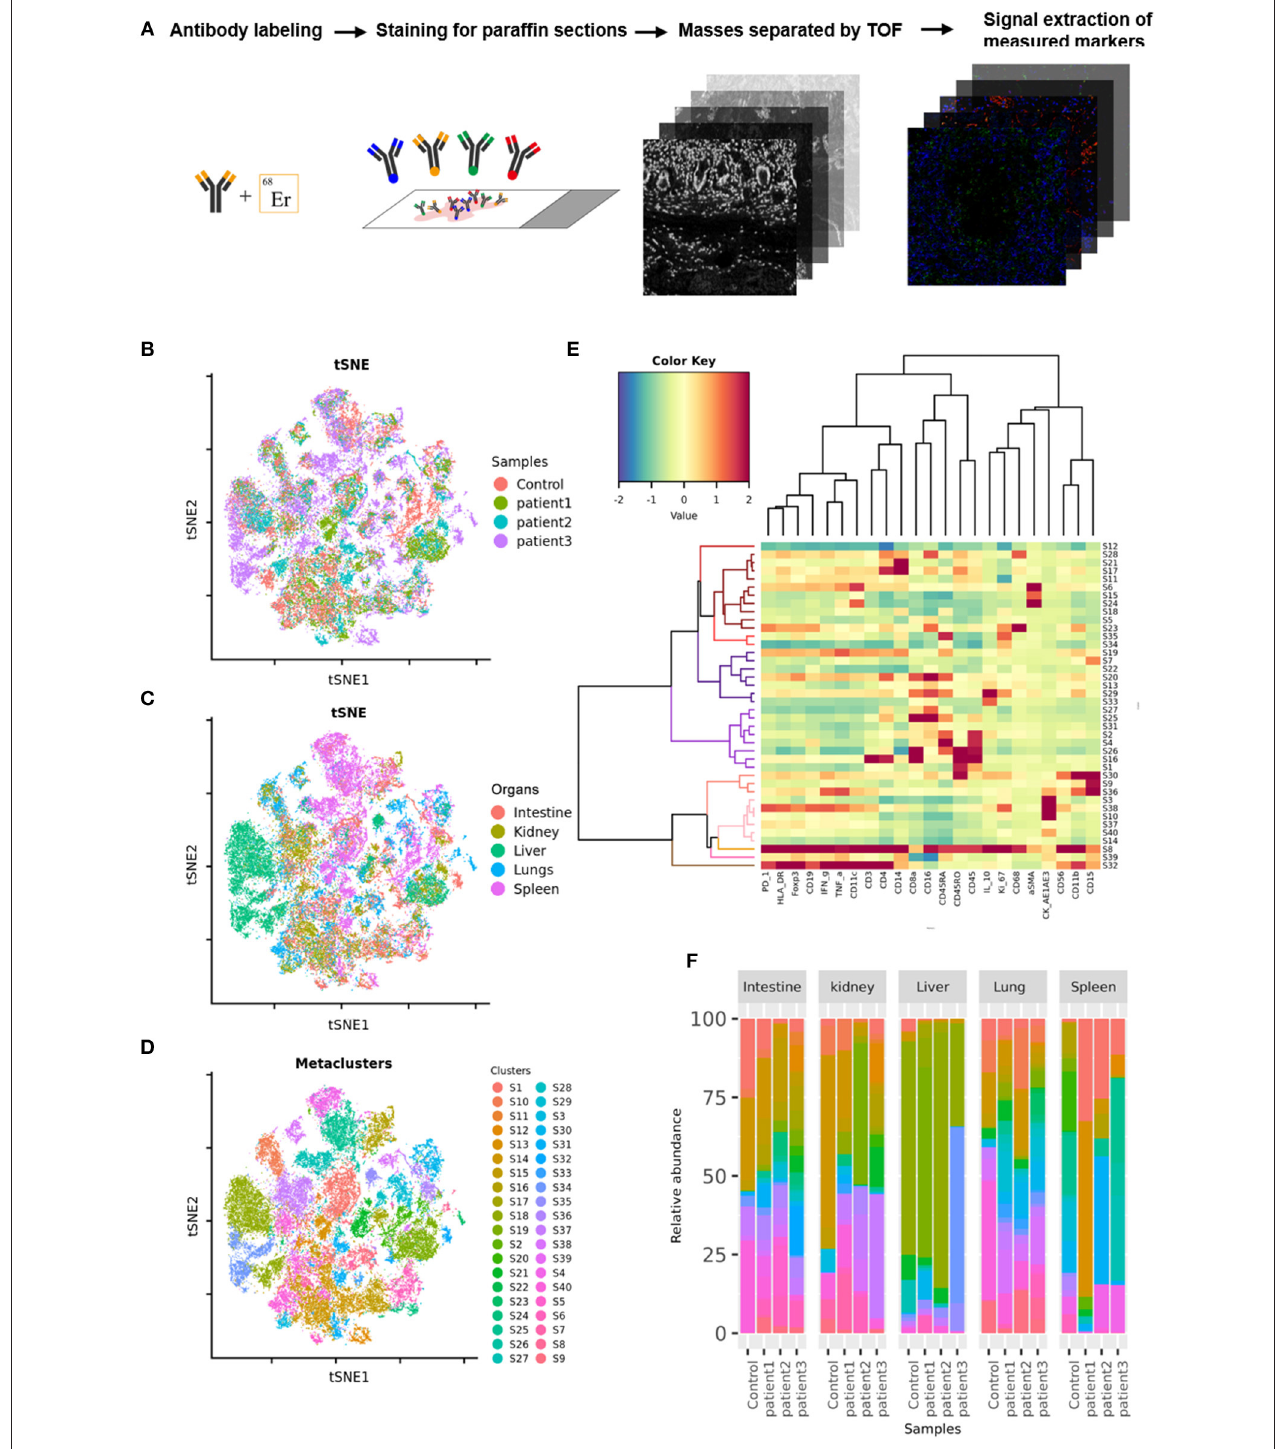
FIGURE 1 | Imaging mass cytometry (IMC) of tissues from patients with coronavirus disease-2019 (COVID-19). (A) Schematic of IMC acquisition for multiplexed images from three patients with COVID-19 and controls. (B) t-SNE map displaying 55,391 subsampled single cells from each PhenoGraph cluster identified in heatmap images colored according to sample. (C) t-SNE map displaying 55,391 subsampled single cells from each PhenoGraph cluster identified in heatmap images colored according to organ. (D) t-SNE map displaying 55,391 subsampled single cells from each PhenoGraph cluster identified in heatmap images colored according to cluster. (E) Heatmap showing the z-scored mean marker expression of the panel markers for each PhenoGraph cluster. Clusters and markers are grouped according to expression profiles. (F) Bar plots showing the relative percent abundances of the cell clusters.